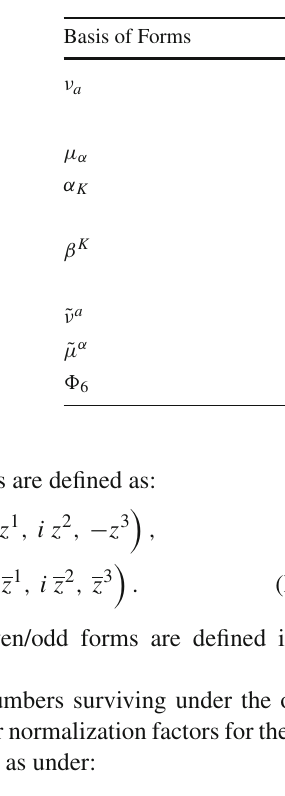
Table 8 Bases of the various non-trivial forms for Model B